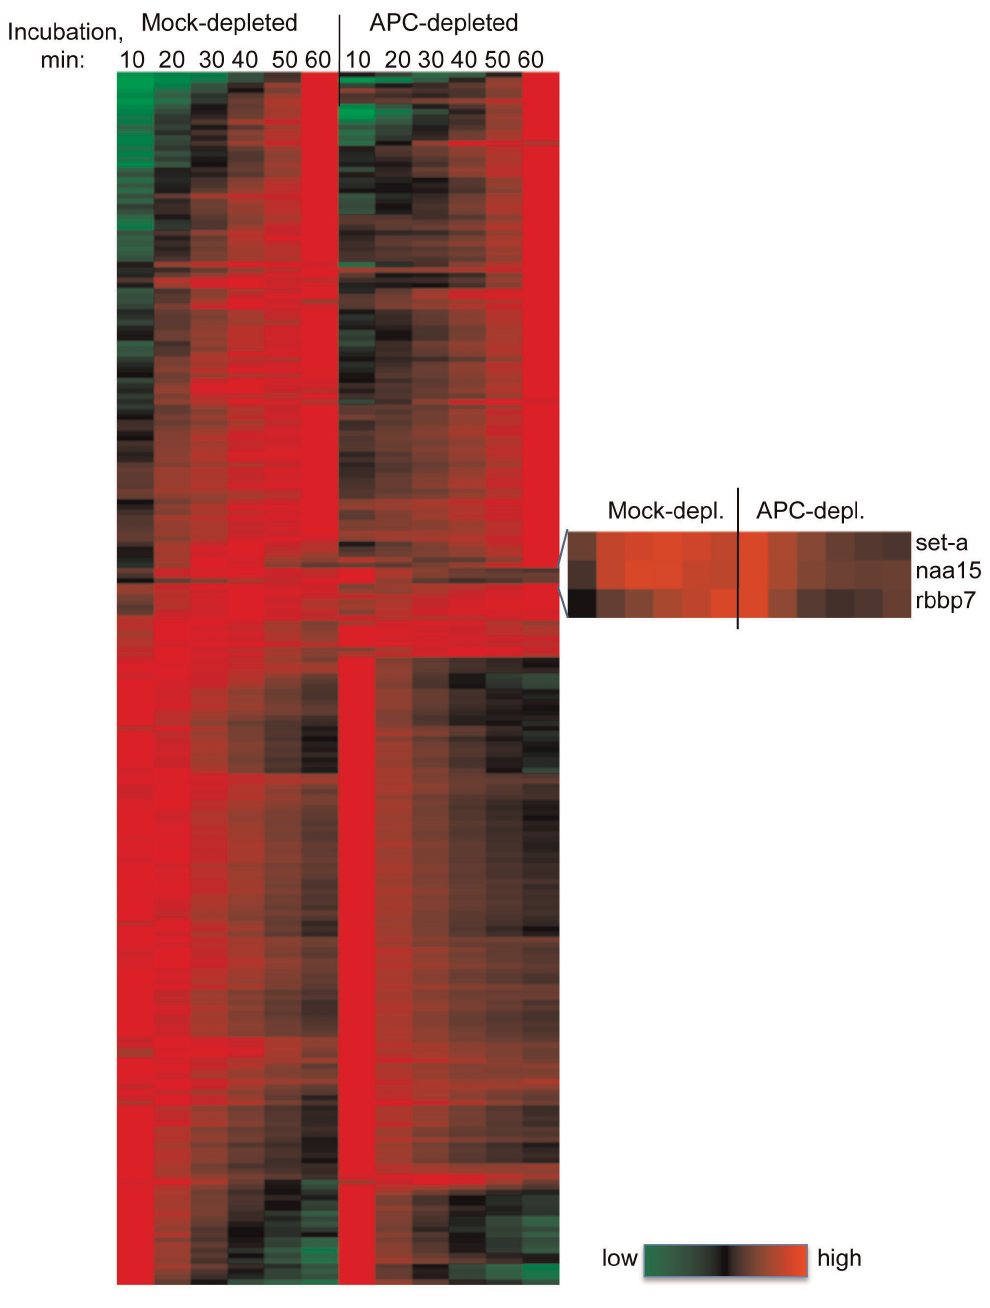
Figure 4. Temporal chromatin association profiles of proteins identified in proteomic screen in APC-depleted and control extracts. Data from 231 protein ID’s that display similar dynamics in all eight analyses (in three independent extracts, see Fig. 3 D) were clustered using TreeView, and displayed as a heat map. Green, black and red represent low, intermediate and high signal, respectively. An enlarged insert depicts a cluster of proteins with dynamics that vary significantly after APC depletion.